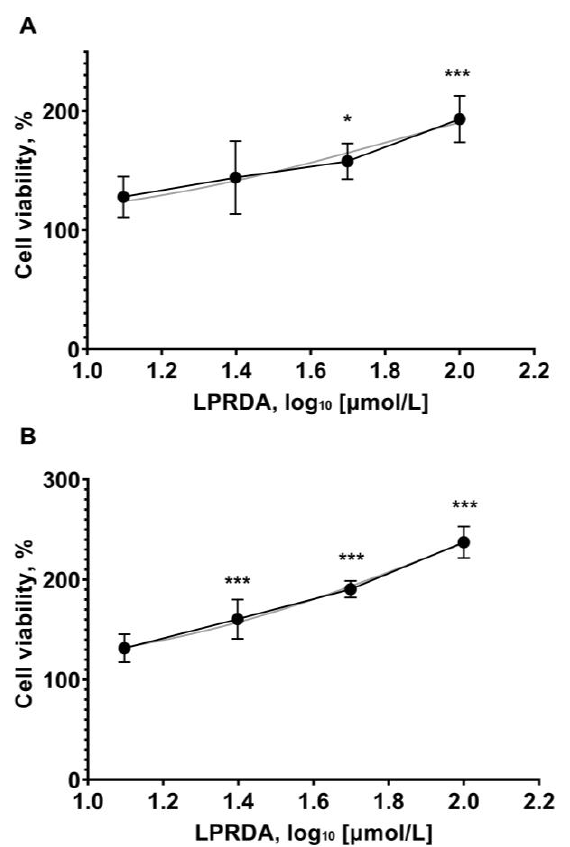
Figure 5. Viability of Vero cells after 72 h of incubation with LPRDA. Initial cell seeding concentration ( A ) 2000 cells/well and ( B ) 1000 cells/well. Dots represent LPRDA concentrations (12.5, 25, 50, and 100 µmol/L). * p < 0.05 ; *** p < 0.01 .